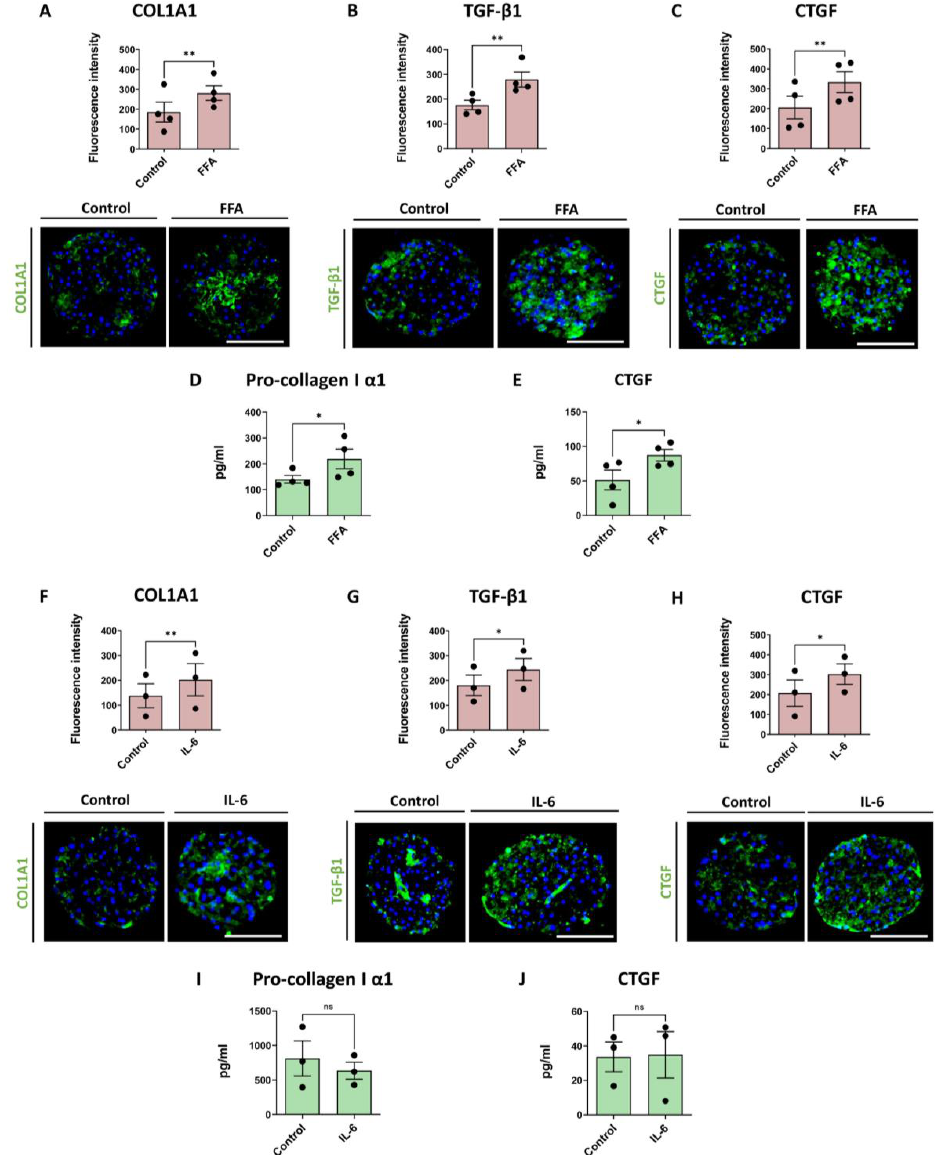
Figure 3. FFA and IL-6 treatment increase fibrosis markers and CTGF production in co-cultures. Red bars represent results of IHC analysis and green bars represent data based on ELISA analyses. CTGF in the spheroids (n = 4). ( D , E ) FFA treatment increased pro-collagen I α 1 and CTGF released from the cells into the medium during the last 2 days of culture (n = 4). ( F – H ) Treatment of the spheroids with 1.5 ng/mL of IL-6 for 7 days increased production of COL1A1, TGF- β 1 and CTGF (n = 3), ( I , J ) but not of pro-collagen I α 1 and CTGF production monitored by ELISA (n = 3). Every dot in the plots represents data from 1 experiment. Every dot in the red bars represents an average of at least 10 analyzed sections of spheroids per experiment. The size of the spheroids is marked with a white scale bar of 100 µ m. Data are shown as mean ± SEM. Statistical analysis—Student’s t -test; * p < 0.05; ** p < 0.01; ns: not